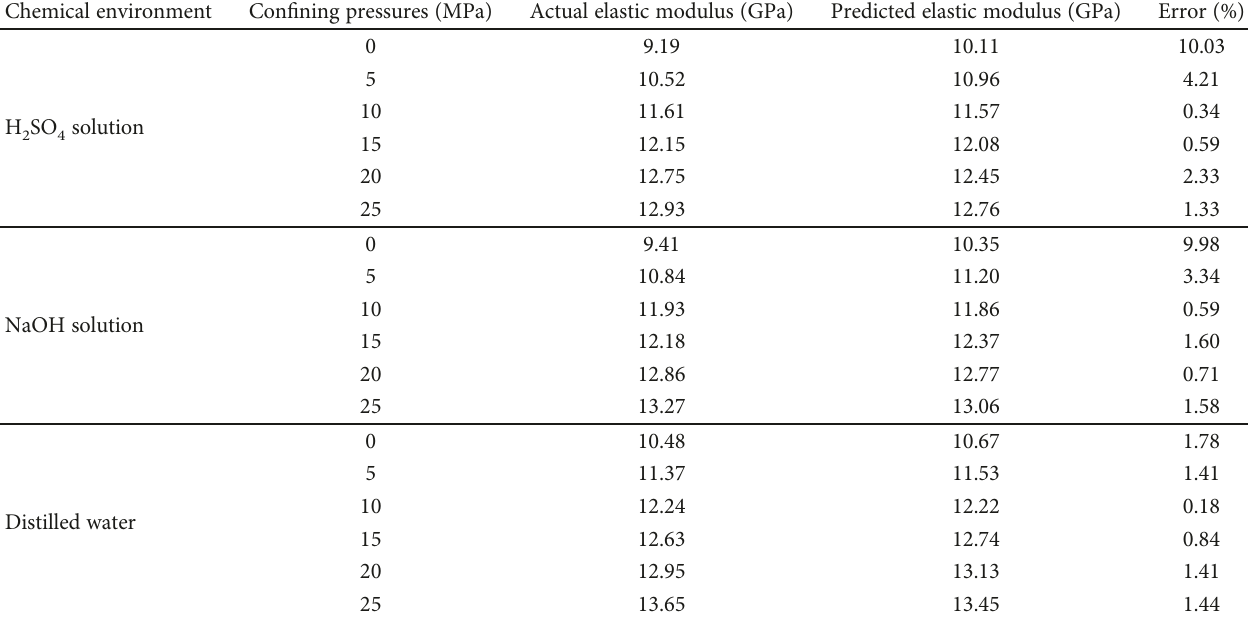
Table 3: Elastic modulus of sandstone specimens treated with chemical corrosion at various con fi ning pressures. Chemical environment